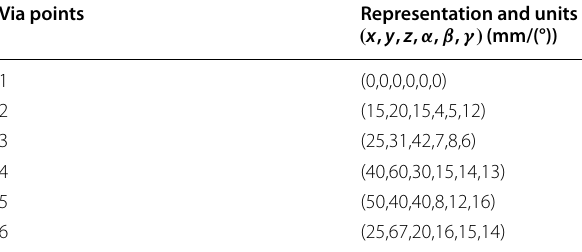
Table 1 Via points in workspace Via points